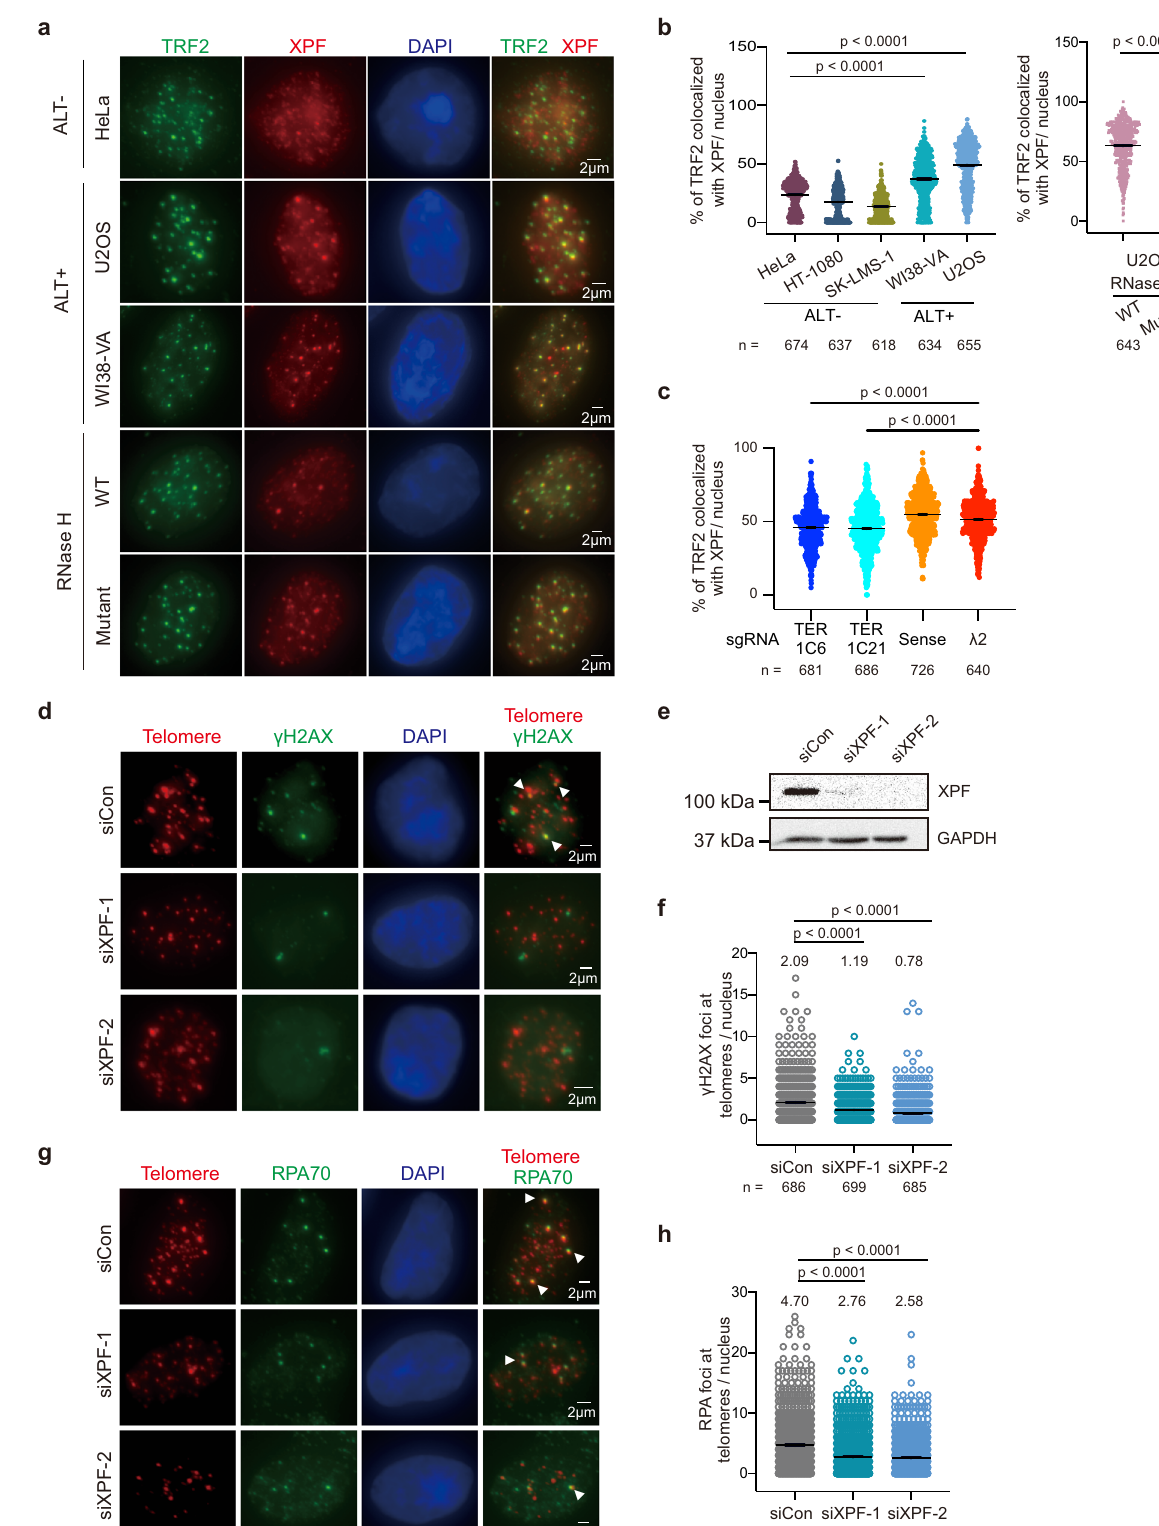
DNA and inhibit topoisomerase II to generate DSBs 57,58 . Cisplatin par- ticularly reacts with the nucleophilic N7-sites of purine bases and causesDNAdamage 59 . Ourresultsindicated thatU2OS cellswere more resistant to doxorubicin, etoposide and cisplatin, in comparison to non-ALT cells (Fig. 7c, Supplementary Fig. 8e). WI38-VA cells were more resistant to doxorubicin and etoposide compared to non-ALT